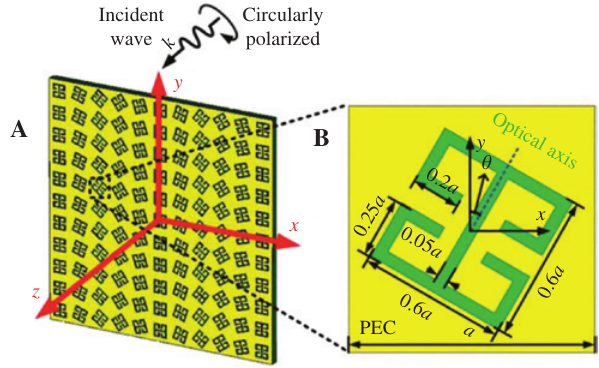
Figure 15: Geometry of the Ding’s high efficient metallic metas- urface lens. (A) Schematic of the metasurface lens. (B) Geometric parameters of the unit cell. Adapted from Ref.